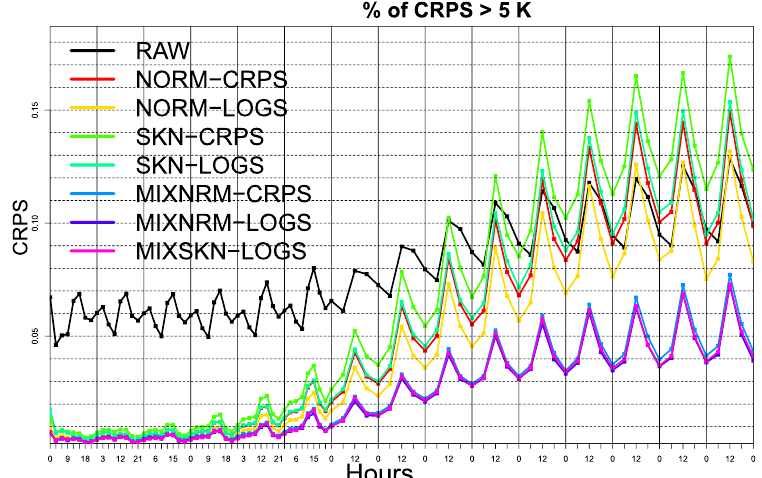
Figure 5. Percentage of CRPS (for each day/station) larger than 5 ◦ C along lead times. There is a clear improvement of the large errors, especially with the mixture models and after Day 10.